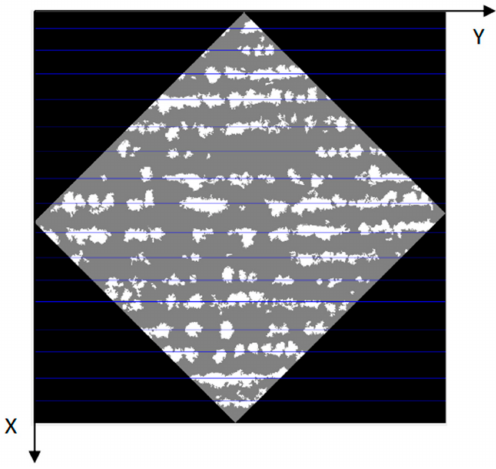
Figure 5. Diagram of the centerlines (in blue) of the seedling